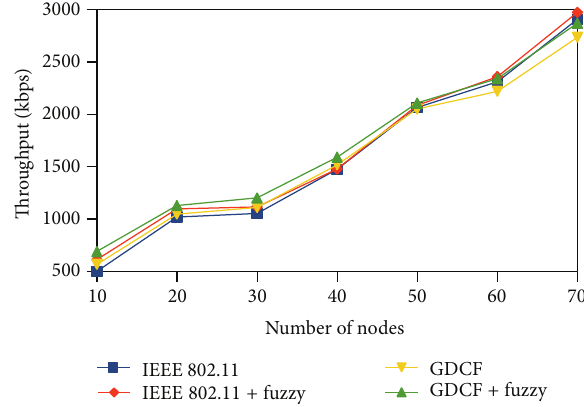
Figure 8: Average throughput for 500 ∗ 500 scenario.